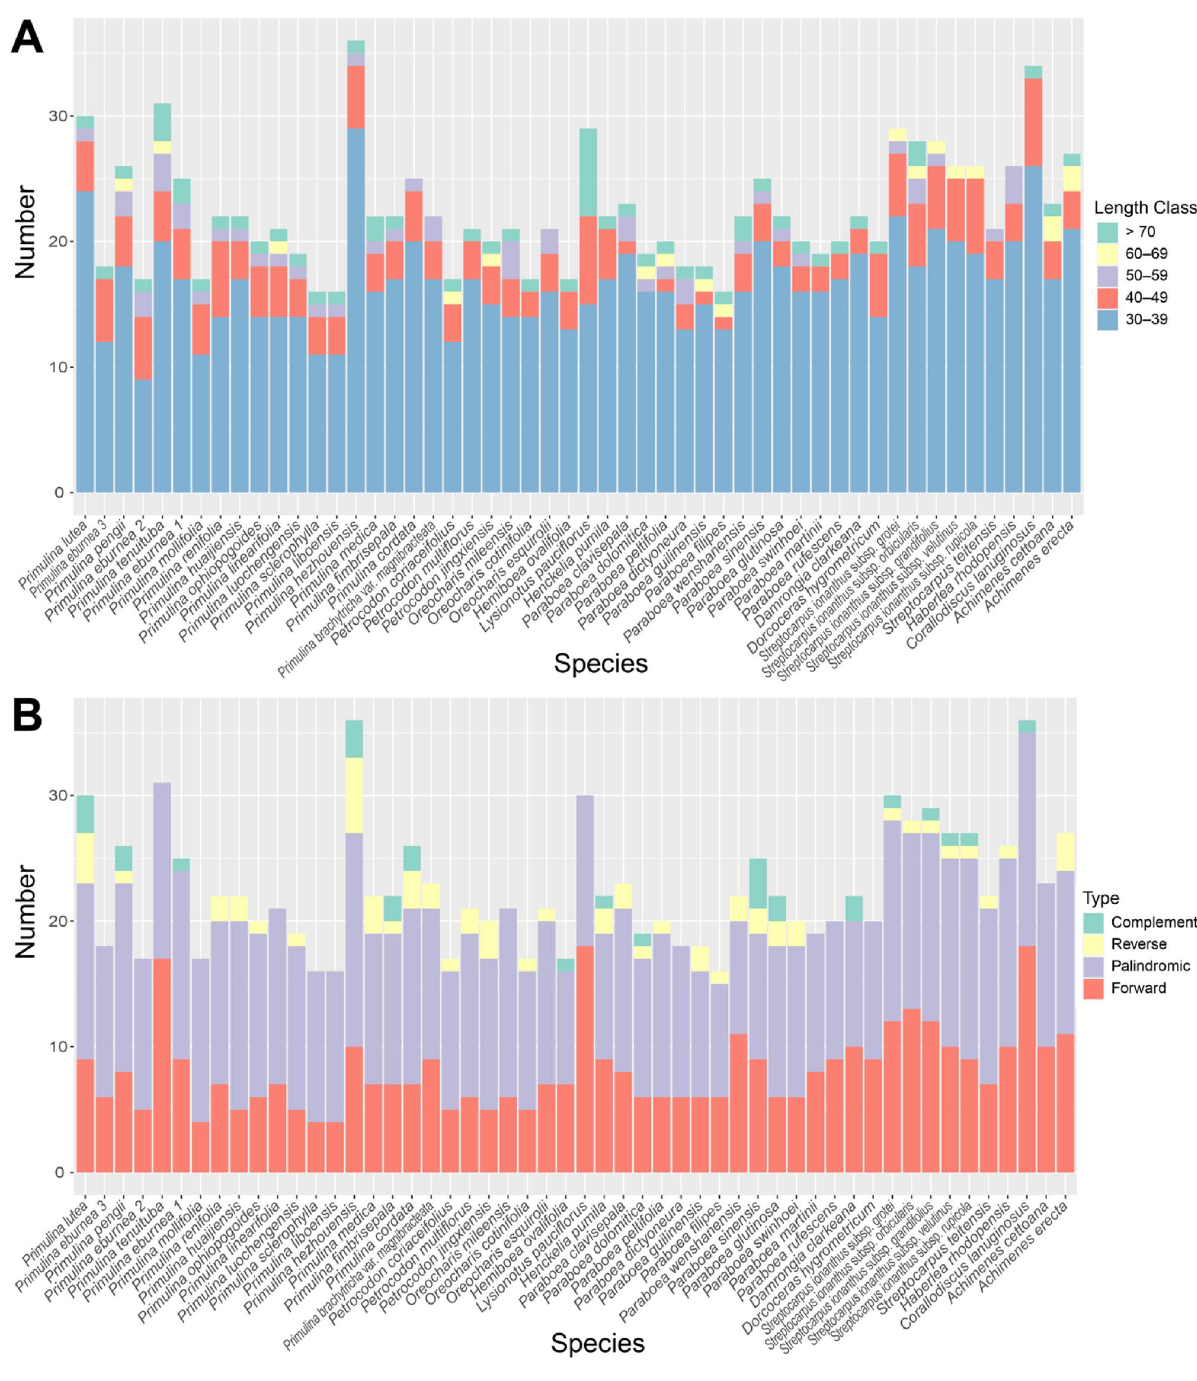
Figure 4. The statistics of long repeat contents in 52 Gesneriaceae plastomes with one IR excluded. ( A ) The length distribution of long repeats in five length classes. ( B ) The number of four types of long repeats in